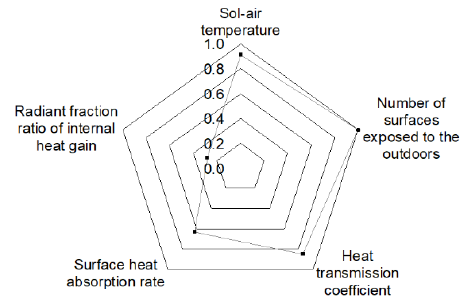
Figure 16. Impact of factors on boundary condition.